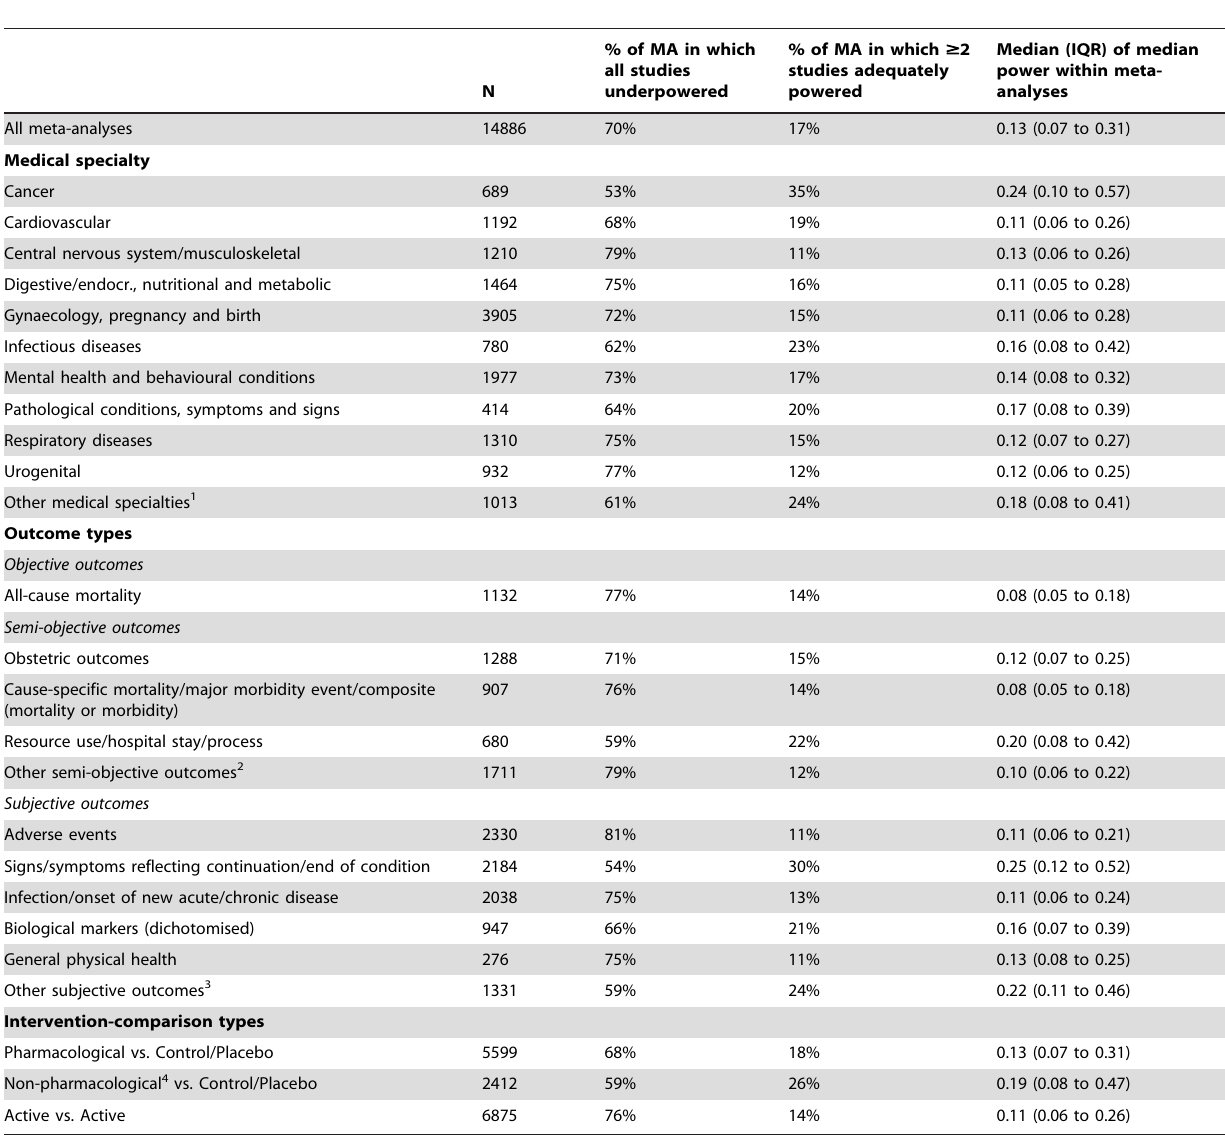
Table 2. Numbers of adequately powered studies ( $ 50% power) and median power within each meta-analysis (MA) with respect to a 30% relative risk reduction ( RRR30 ), overall and by medical specialty, outcome type and intervention-comparison